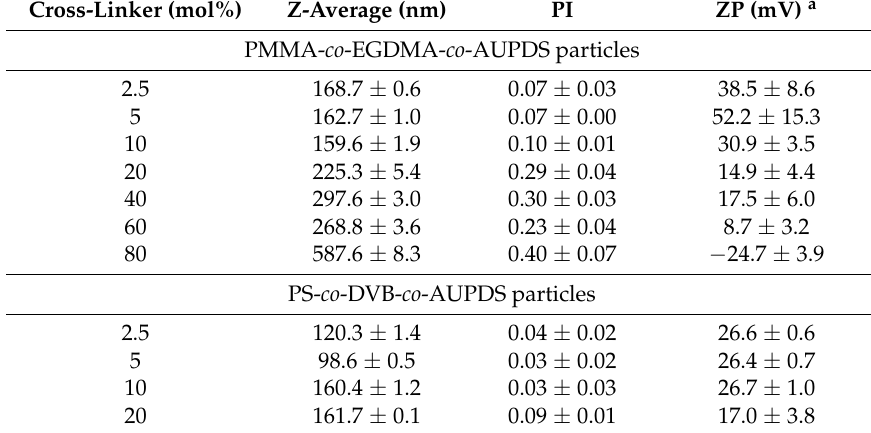
Table 2. Z-average hydrodynamic diameters, polydispersity index (PI) and zeta potential (ZP) values obtained for PMMA- co -EGDMA- co -AUPDS and PS- co -DVB- co -AUPDS particles with different amounts of EGDMA or DVB cross-linker. Values are presented in average ± standard deviation ( n = 3). Cross-Linker (mol%)